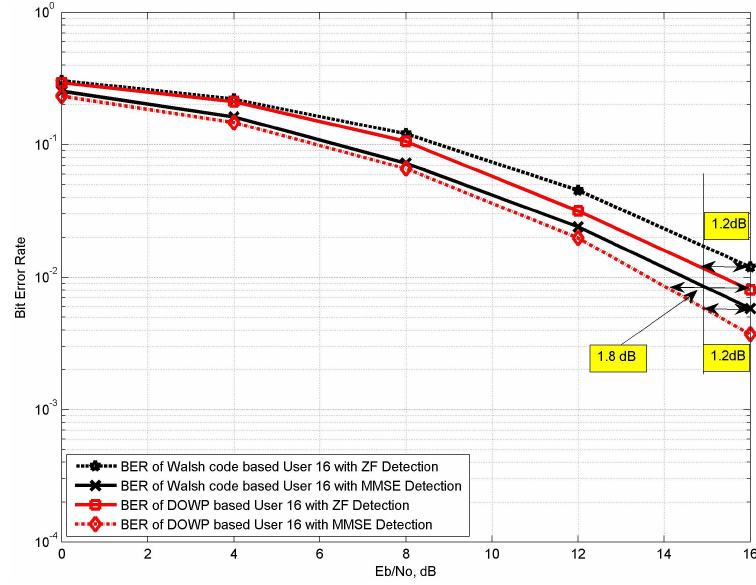
Figure 12. BER Results of traditional and Proposed VLC Systems.